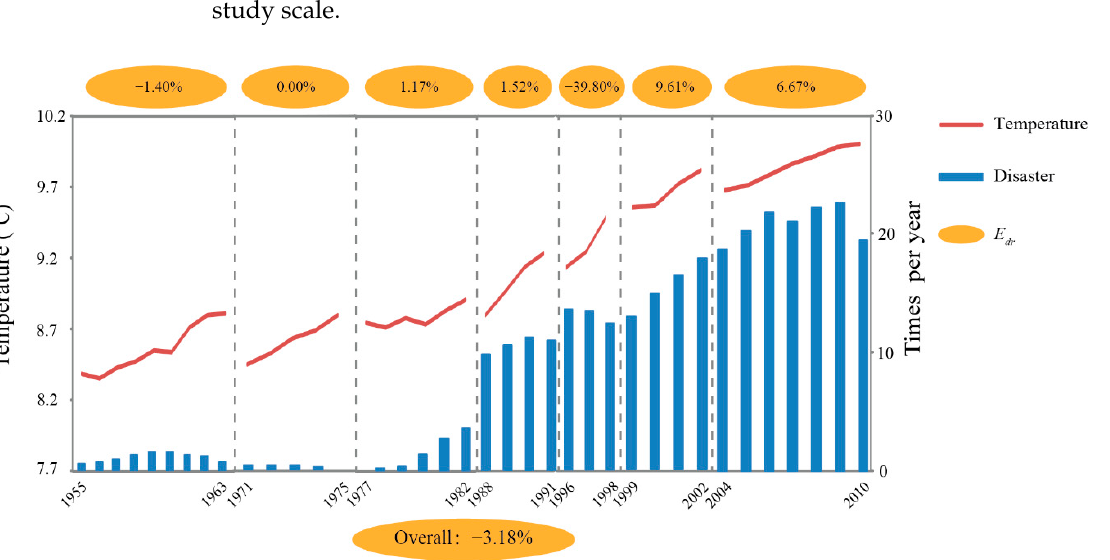
Figure 5. The arc elasticity coefficient ( E dr ) of 5-YMAT and ACND during temperature-rise periods. The coefficient values for each temperature cycle period are shown in the ovals above the figure. The corresponding coefficient for the entire temperature-rise period is shown in the oval below the figure.